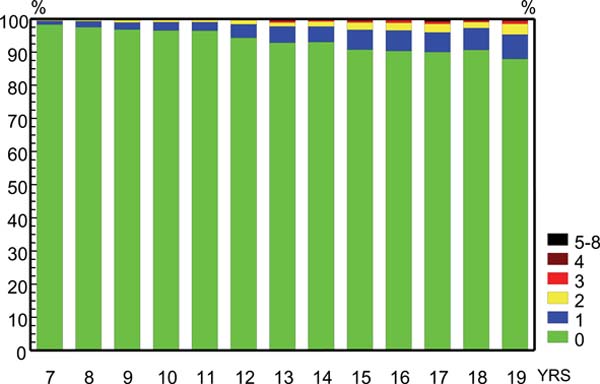
Caries incidence in Värmland 1999. DS-TOT frequency distribution